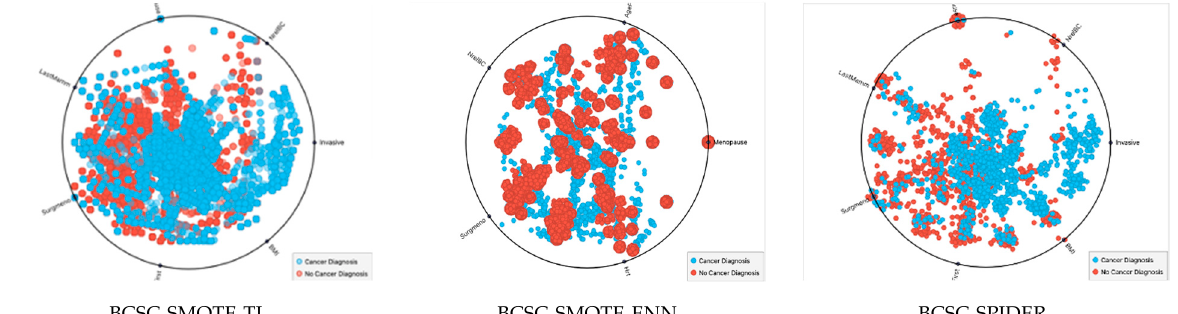
Figure 6. Effect of oversampling techniques on the BCSC dataset.